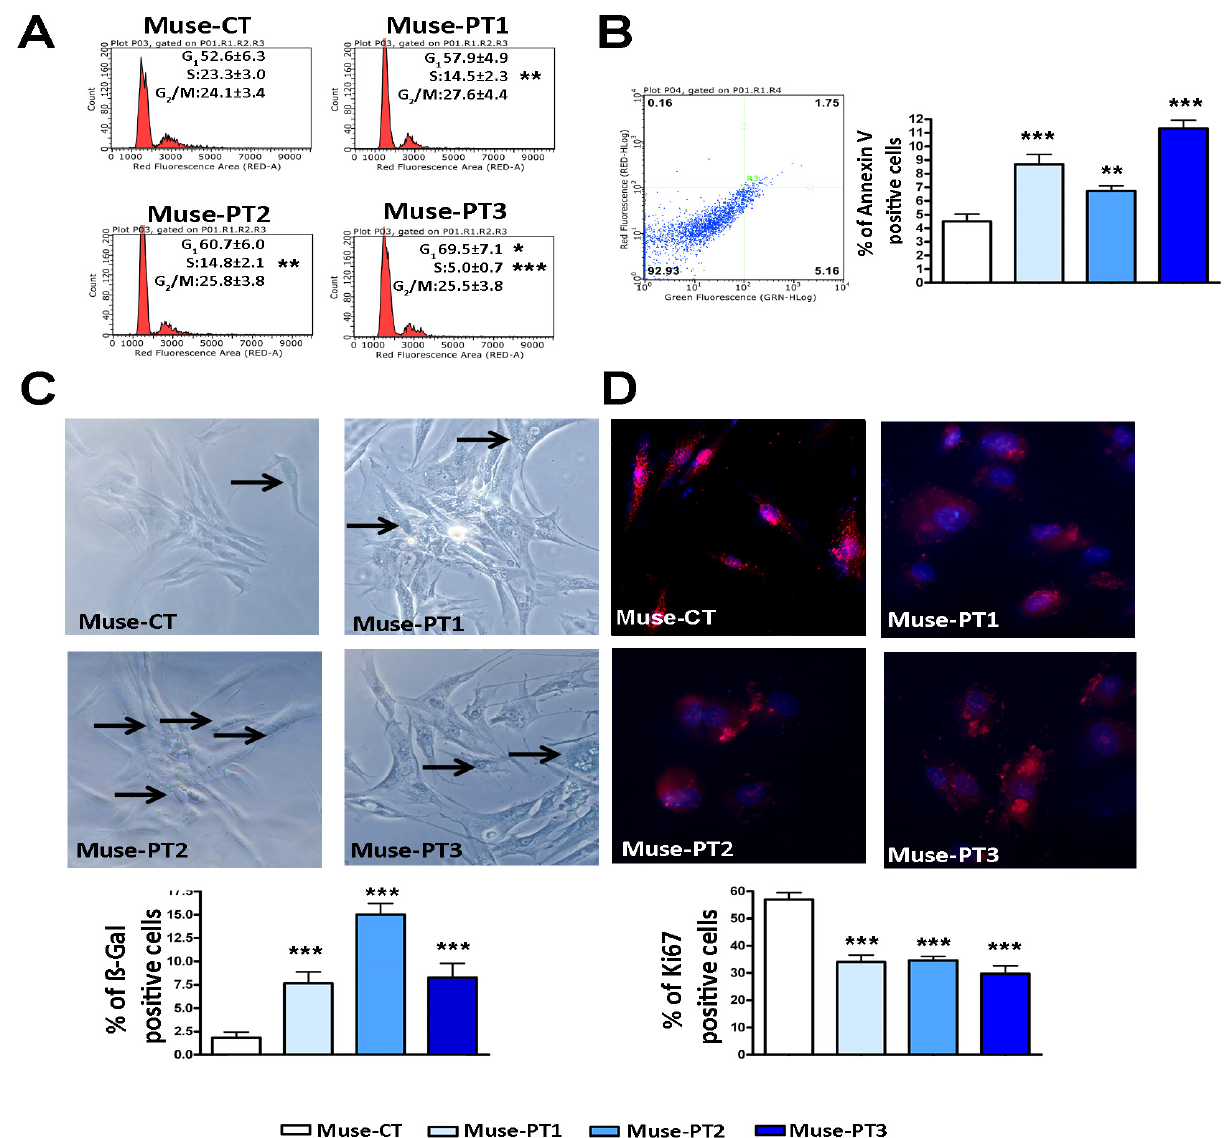
Figure 2. Biological parameters of patients’ Muse cells. Panel ( A ): Representative plots of cell cycle analysis on Muse stem cells. Panel ( B ): Example of annexin assay performed on Muse stem cells. The percentage of apoptotic cells in the different samples is shown in the graph. Panels ( C , D ): Representative images of beta-galactosidase assay ( C ) and Ki67 immunostaining ( D ) performed on Muse stem cells (200 × magnification). The immunostaining identified the Ki67 positive cells, shown in red, while the nuclei were stained with DAPI in blue. In Panel ( C ), some senescent cells in blue are indicated with an arrow. The graphs indicate the percentages of (beta-gal+) senescent cells and (Ki67+) cycling cells, respectively. For all of the experiments, the symbols *** (i.e., p < 0.001), ** (i.e., p < 0.01), and * (i.e., p < 0.05) indicate statistical significance between the healthy control and the patients’ samples. For every sample, three biological replicates were performed, and data are reported with SDs.